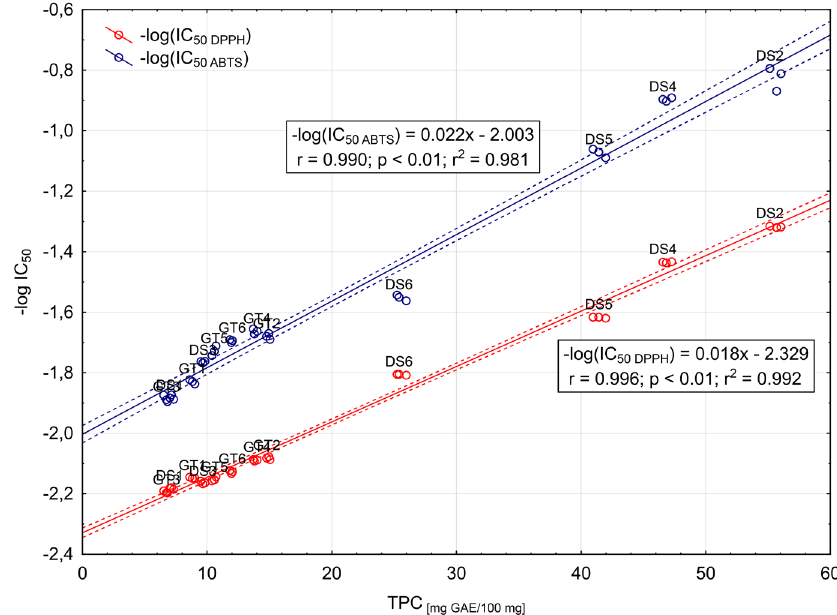
Figure 5. Scatterplot of -log(IC